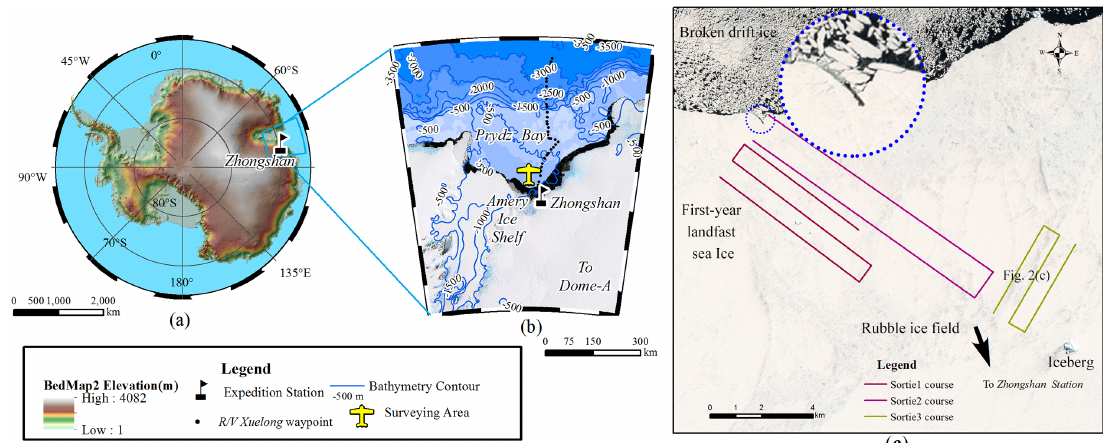
Figure 1. Study site and Chinese Antarctic expedition settings. ( a ) The location of the Chinese flagship scientific research station, Zhongshan, in east Antarctica, overlaid on the Bedmap2 Antarctic ice sheet surface elevation map. ( b ) The coastal environment near Zhongshan station. In November each year, R/V Xuelong usually traverses through westerlies and the drift ice zone of the Prydz Bay to approach and re-supply the polar expedition team. The landfast sea ice near shore often extends 30–40 km from the Larsemann Hills. The background Antarctic ice sheet mosaic is the LIMA from USGS. ( c ) The programmed path of three missions. Note the dashed circle close-up in upper part: The Sentinel-2 optical satellite happened to capture the moment on 29 November 2016, when the R/V Xuelong (black linear feature) was trying to break the outer boundary and pierce into the landfast ice. It was held still a few kilometres past that position, and then anchored